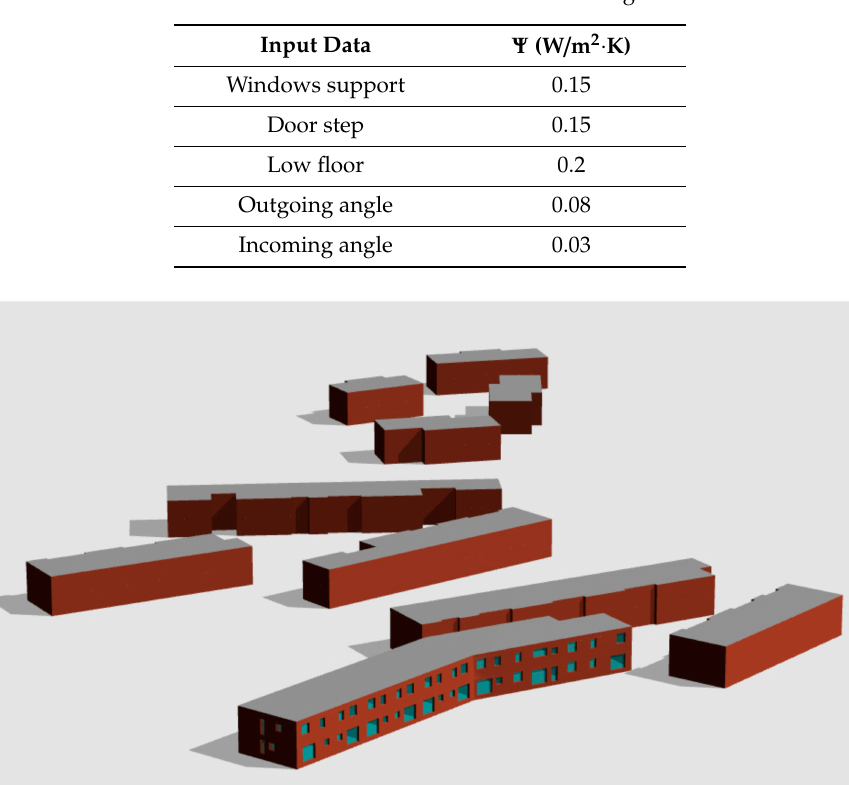
Table 3. Characteristics of the thermal bridges.